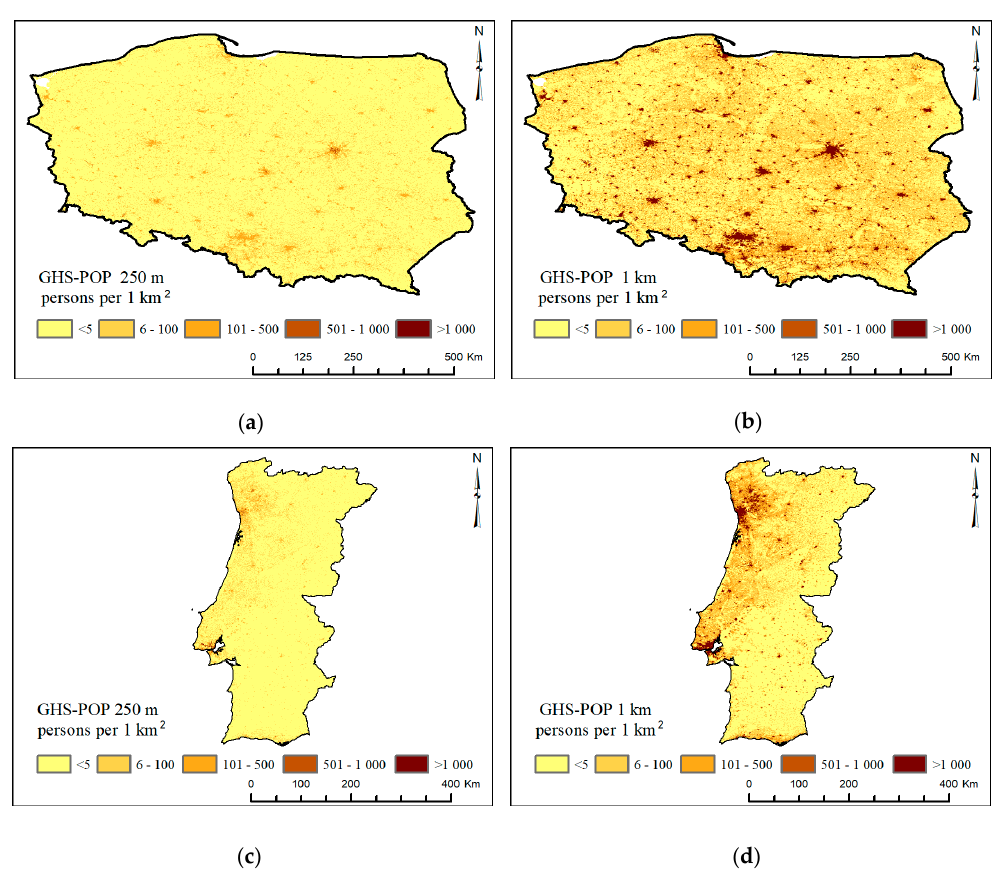
Figure 3. Population distribution by the Global Human Settlement Population Grid (GHS-POP). ( a ) Poland, 250 m grid cells; ( b ) Poland, 1 km grid cells; ( c ) Portugal, 250 m grid cells; ( d ) Portugal, 1 km grid cells.